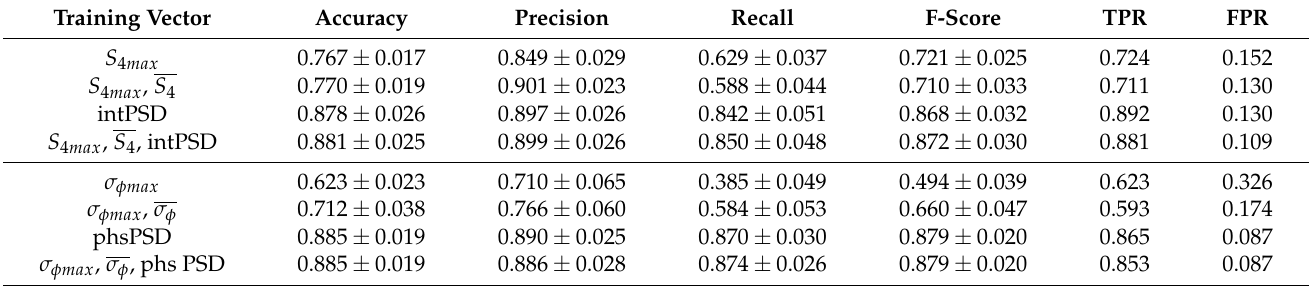
Table 2. Performance overview with optimised linear kernel.